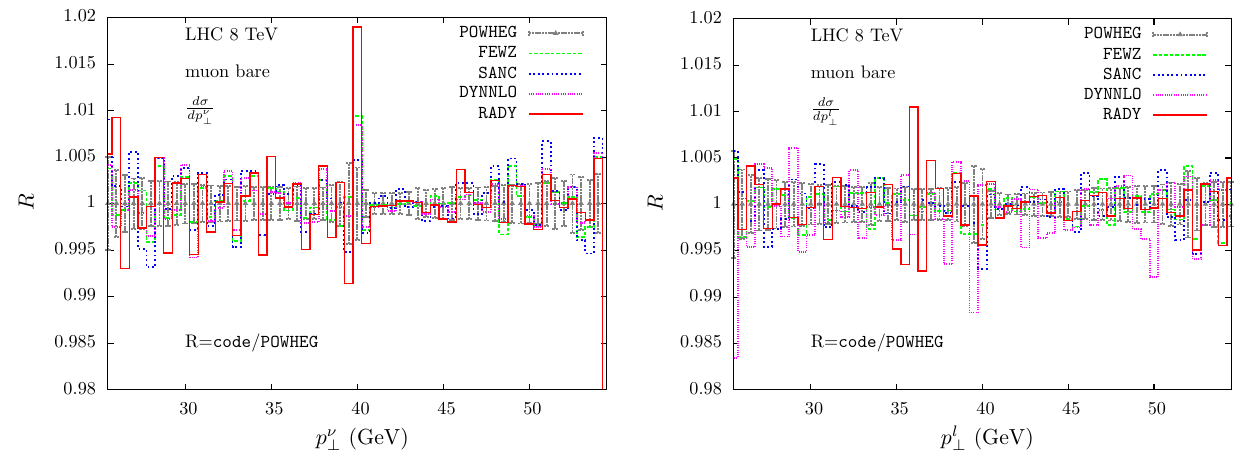
Fig. 9 Tuned comparison of the muon and muon neutrino transverse momentum distributions in pp → W − → μ − ¯ ν μ + X at the 8 TeV LHC with ATLAS/CMS cuts in the bare setup, including NLO QCD corrections